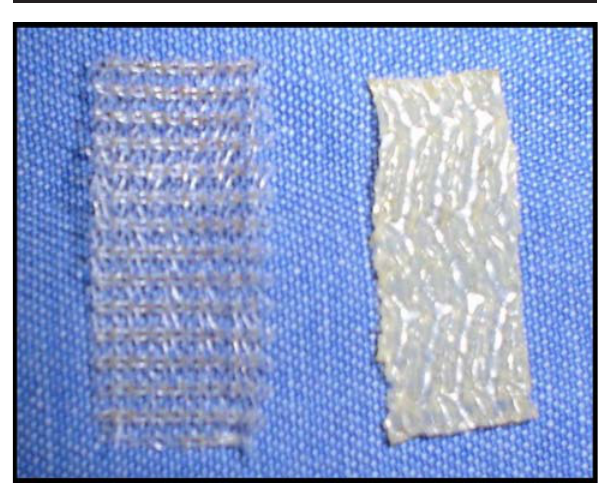
FIGURE 1 - Aspect of polypropylene (left) and latex coated propylene (right)